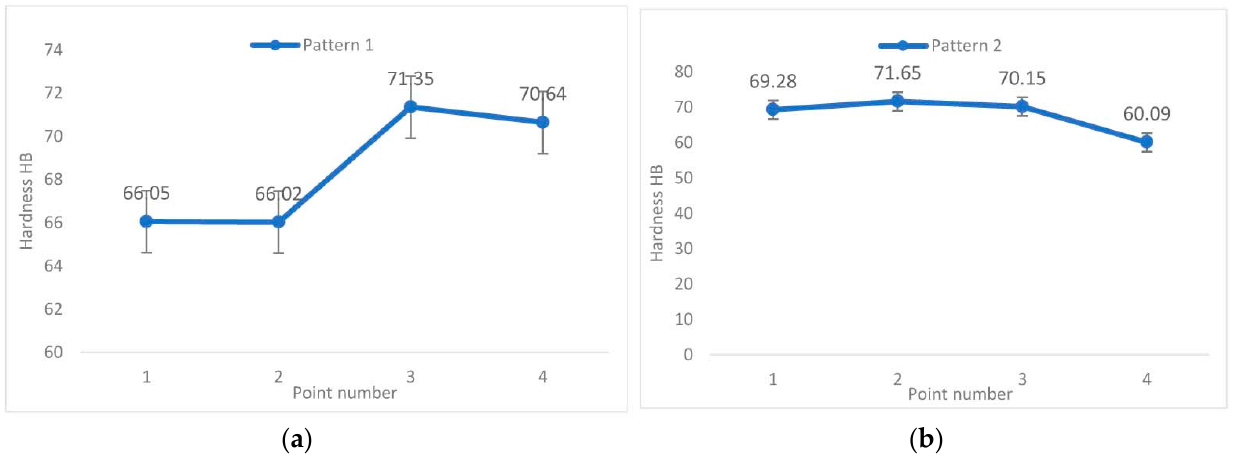
Figure 5. ( a , b ) Graphical representation of the relationship between the Brinell HB hardness of the copper-1 specimen and the cutting feed rate and amps used for four tests pre- and post-PAC. ( a ) Readings for the hardness test pre-cut; ( b ) readings for the hardness test post-cut.